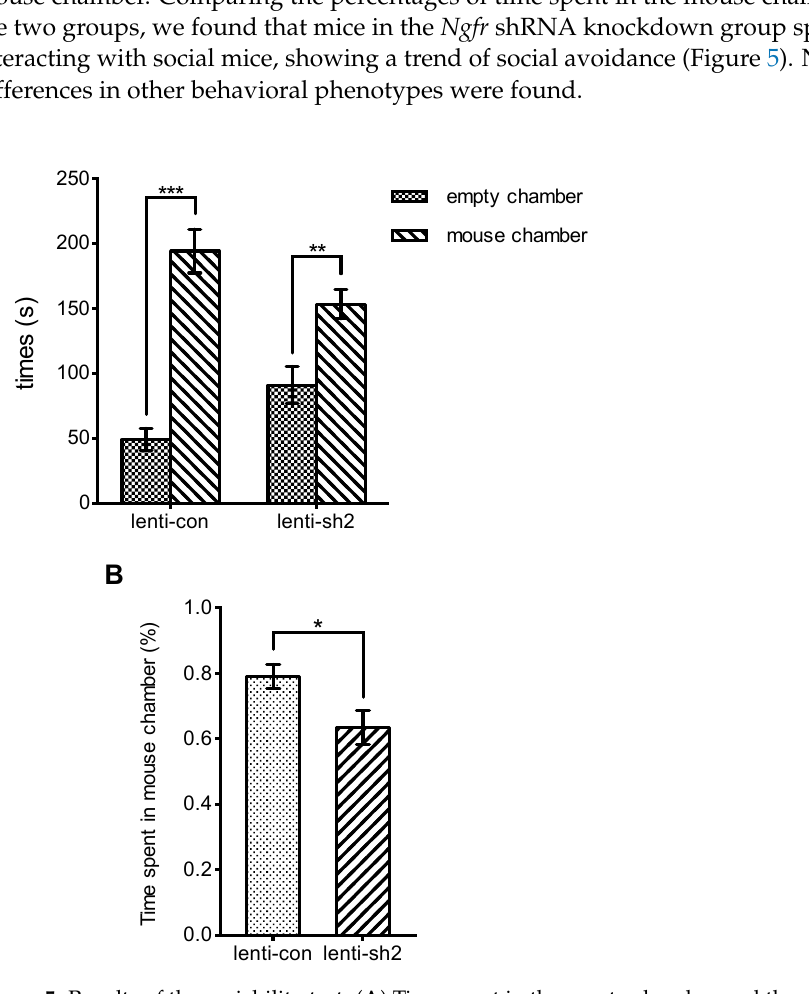
Figure 5. Results of the sociability test. ( A ) Time spent in the empty chamber and the mouse chamber for each mouse. ( B ) Percent of time spent in the mouse chamber was significantly lower for the shRNA mice than control. Results are presented as means ± SEM. *** p < 0.001, ** p < 0.01, * p < 0.05, one-way ANOVA.